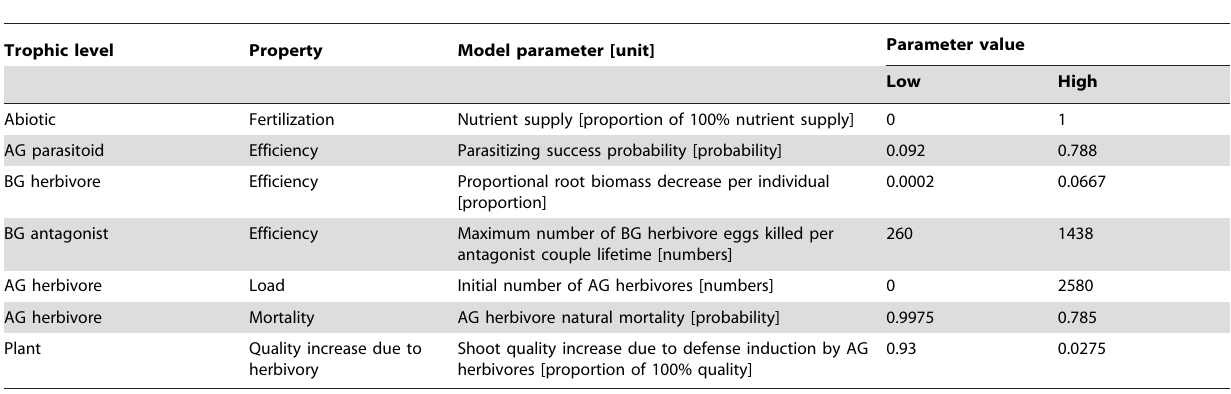
Table 1. Composition of the land use intensity gradient from low to high fertilization and searching efficiencies.